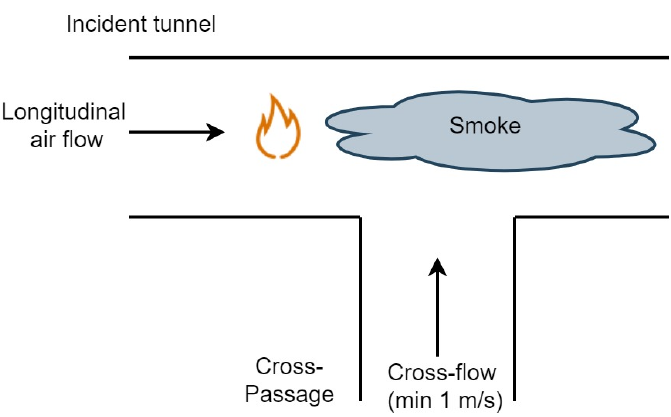
Figure 2. Smoke control in an underground rail cross-passage.